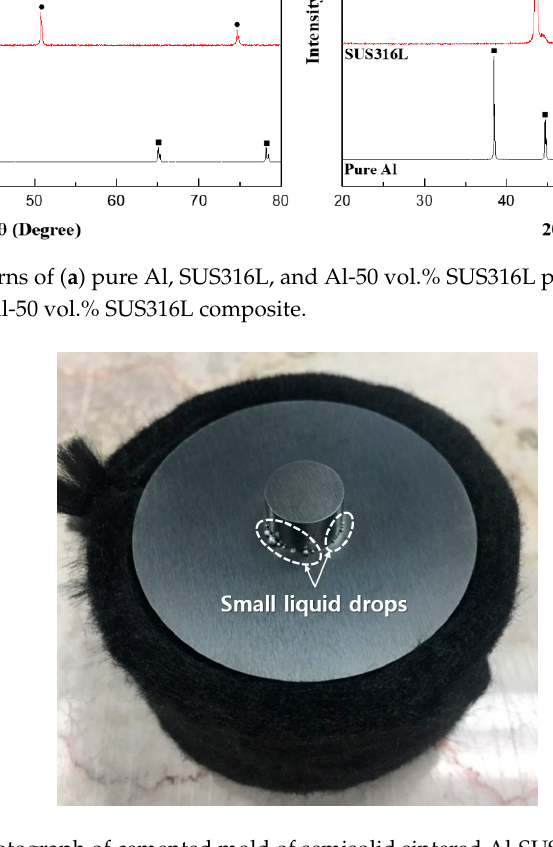
Figure 4. Photograph of cemented mold of semisolid sintered Al-SUS316L composite.